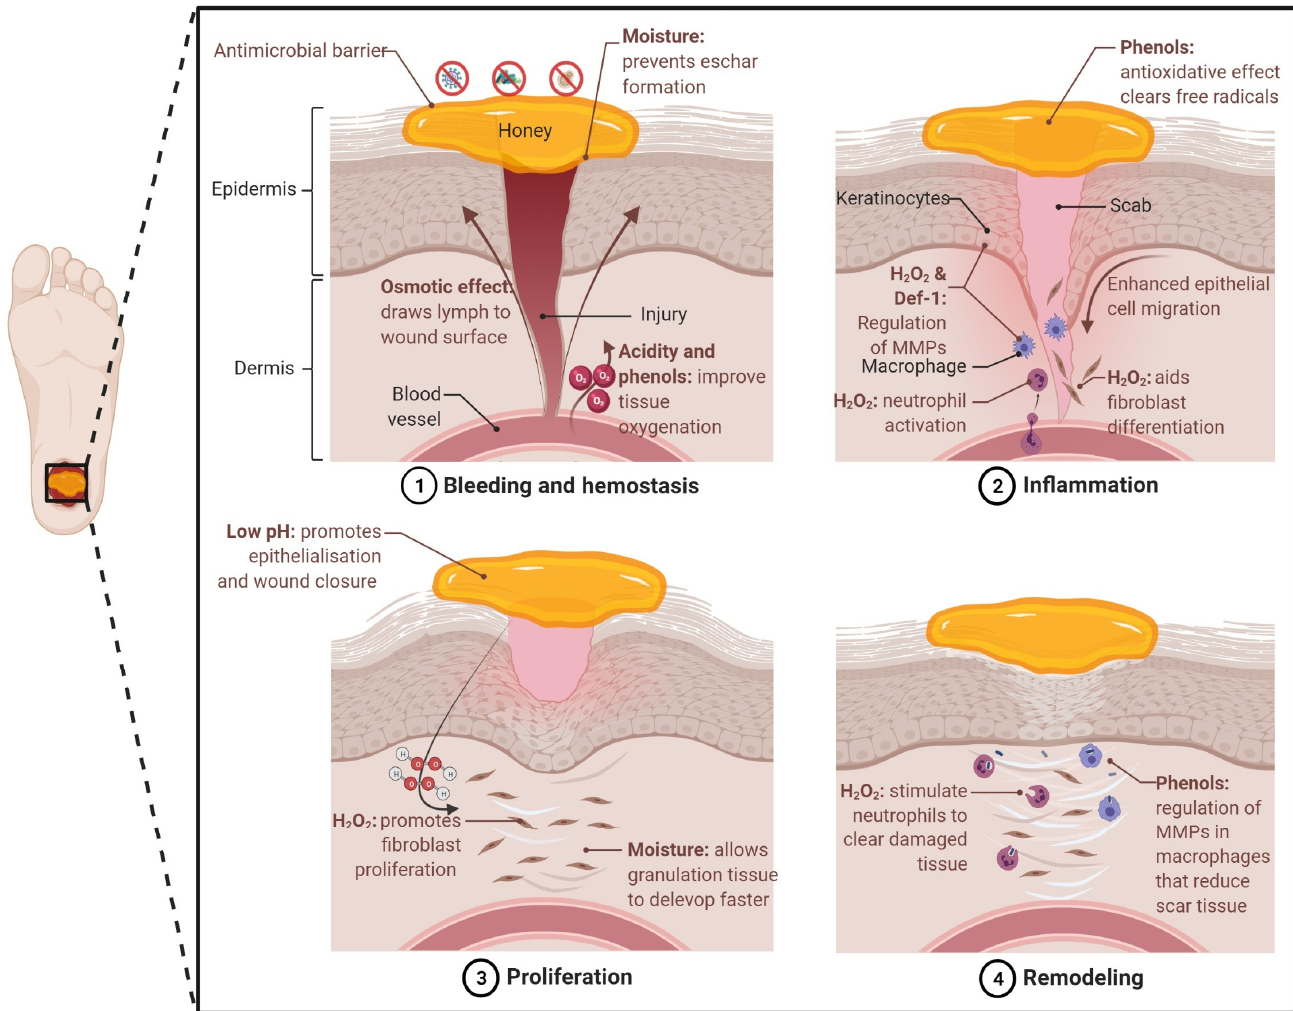
Figure 4. Key factors of honey that contribute to wound healing across all four healing phases. Created with BioRender.com (accessed on 23 February 2022).